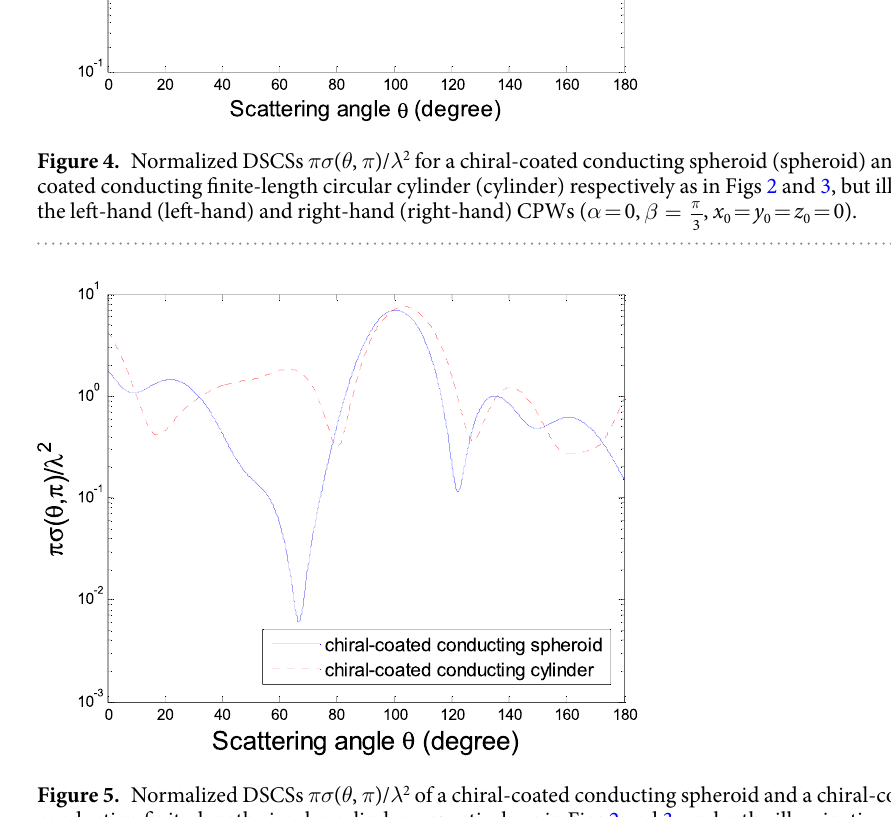
Figure 5. Normalized DSCSs πσ ( θ , π )/ λ 2 of a chiral-coated conducting spheroid and a chiral-coated conducting finite-length circular cylinder respectively as in Figs 2 and 3, under the illumination of a ZOBB ( α = 0, β = π , half-cone angle ζ = π , x 0 = y 0 = z 0 = 4 3